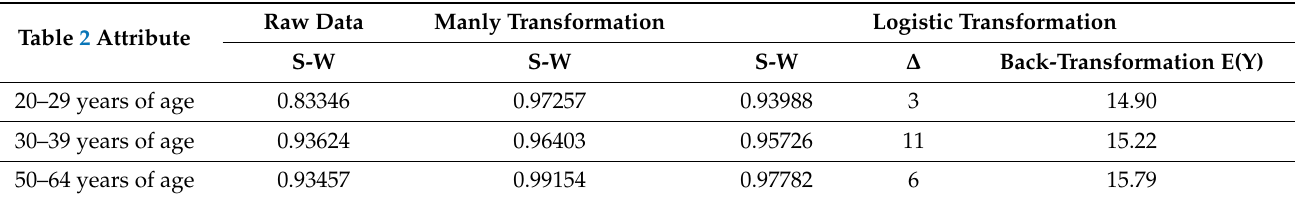
Table 9. Selected specimen attribute summary statistics for the logit back-transformation. Raw Data Manly Table 2 Attribute